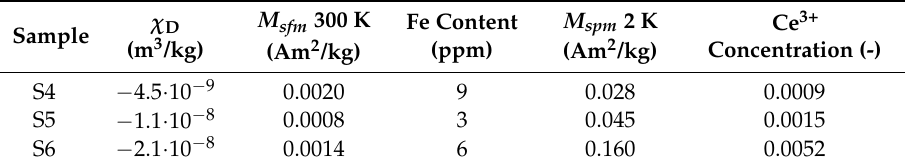
Figure 4. Measured hysteresis loops at 300 K (left panel) and 2 K (middle panel) of the S4 ( a ), S5 ( b ), and S6 ( c ) samples. Paramagnetic contribution is obtained after diamagnetic and ferromagnetic correction and compared to the Brillouin function (right panel). Table 2. Parameters determined from the magnetic measurements and from the Brillouin function: χ D —diamagnetic susceptibility established from 300 K and 2 K hysteresis loops; M sfm 300 K—saturation magnetisation of ferromagnetic contribution at 300 K; M spm 2 K—saturation magnetisation of paramagnetic contribution at 2 K.